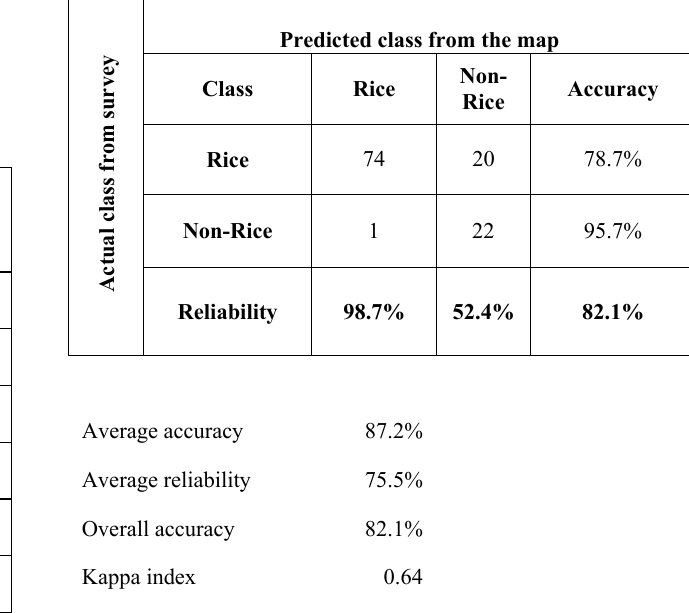
Table.7 Confusion matrix for accuracy assessment of rice